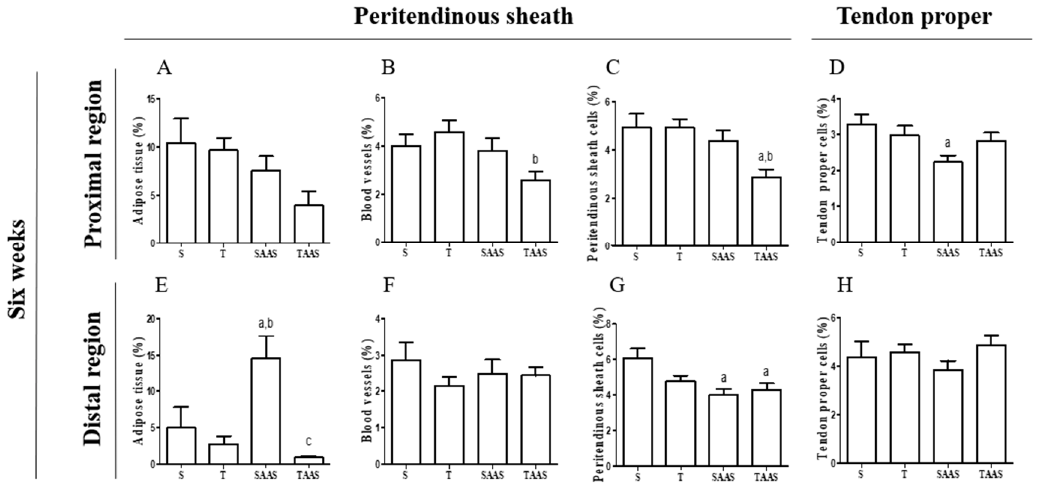
Figure 4. Volume density variation (Vv%) in structural elements found in the proximal and distal regions of the CT in the 6W group and subgroups. Adipose tissue ( A , E ), Blood vessels ( B , F ), Peritendinous sheath cells ( C , G ), Tendon proper cells ( D , H ). Values are expressed as means ± standard error of the mean ( p ≤ 0.05). ( a ) Significant difference vs. 6W-S subgroup, ( b ) significant difference vs. 6W-T subgroup, ( c ) significant difference vs. 6W-SAAS subgroup.